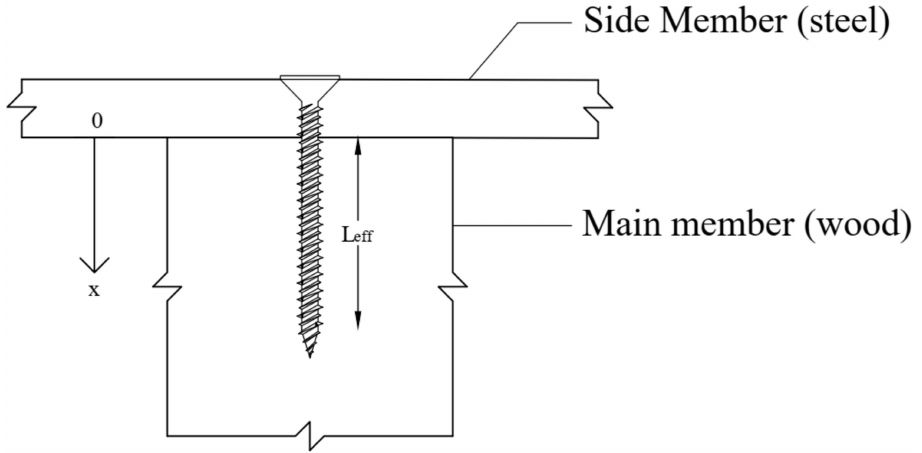
Figure 17. Coordinate system for screw stress